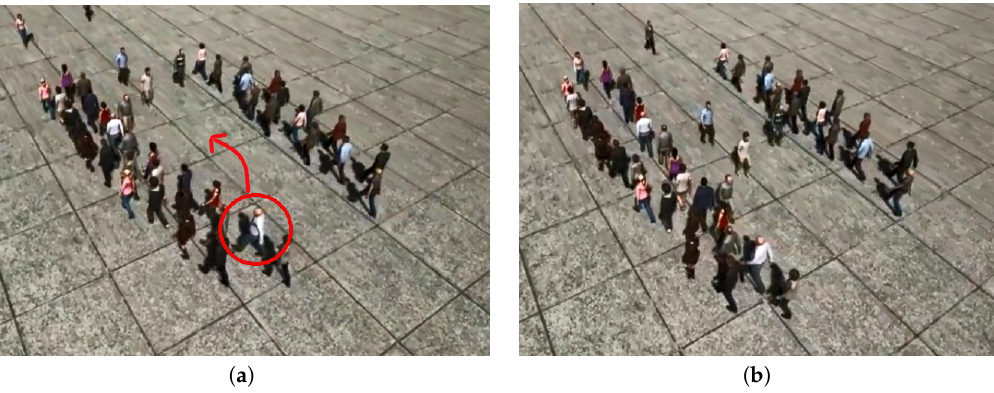
Figure 9. A group confronting individual agents coming from the opposite direction, according to [1]: ( a ) Although the agent in the red square has enough space to walk without any change in the group’s formation, it just follows its connected-agents without awareness of the surrounded area. This behavior makes unnecessary movements for all agents. ( b ) The big gap between the subgroups resulting from a small number of opposite agents is noticeable in this frame.